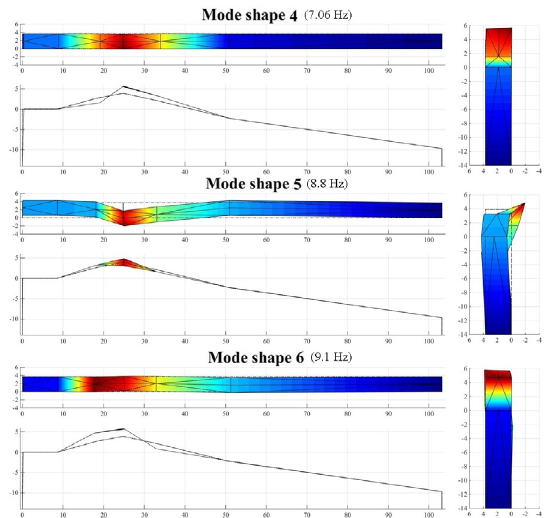
Figure 12. The fourth, fifth and sixth mode shapes of the brid- ge evaluated experimentally: plane, frontal and lateral views. The grey line represents the undeformed shape.